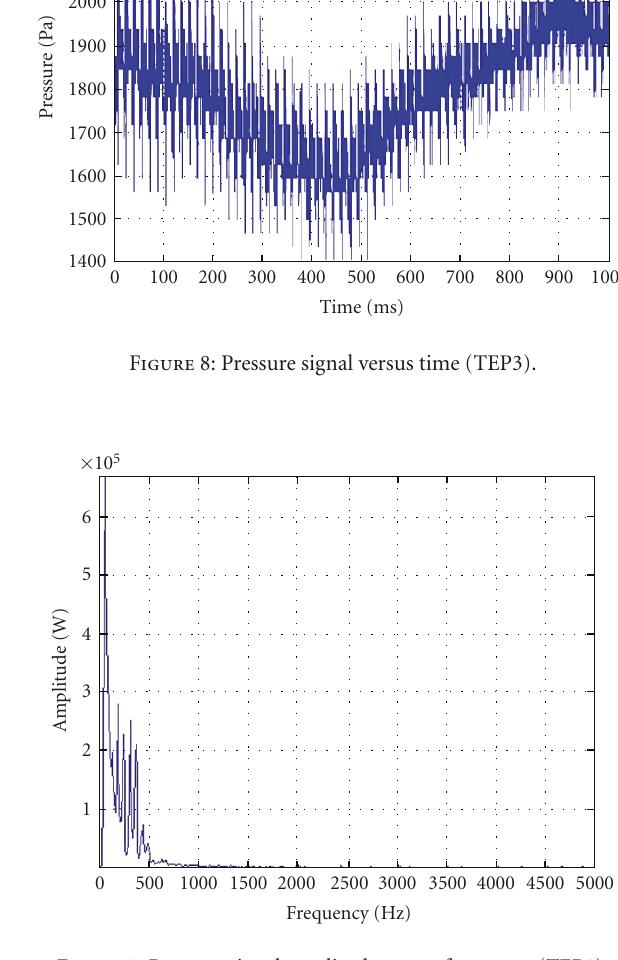
Figure 9: Pressure signal amplitude versus frequency